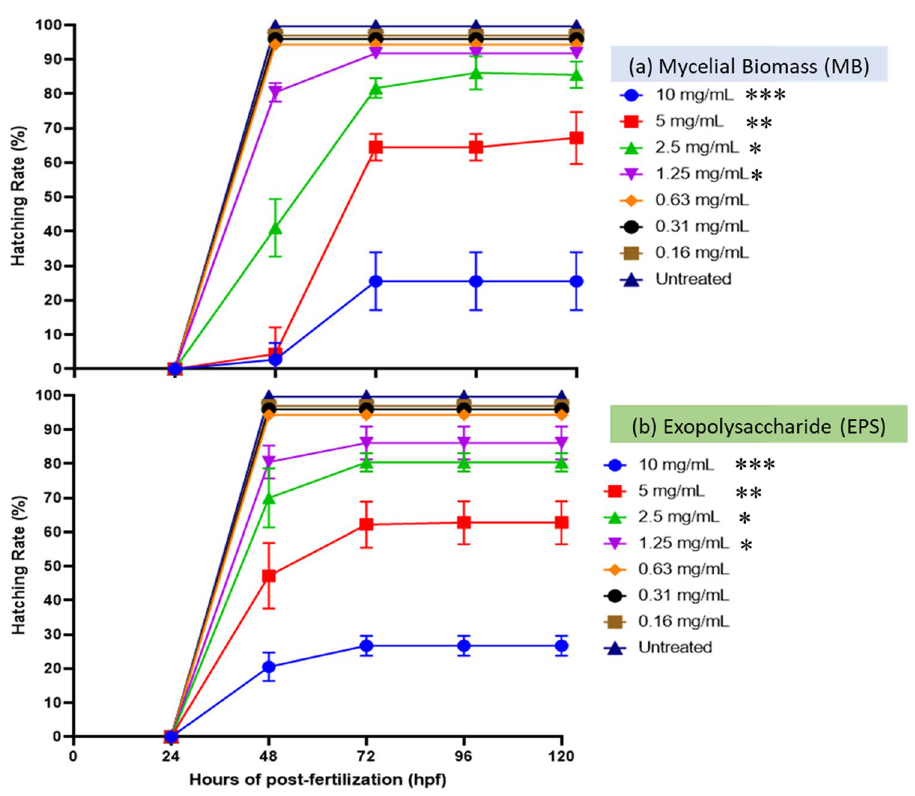
Figure 3. Hatching rate of zebrafish embryos at 0 to 120 HPF with Tiger milk mushroom Lignosus rhinocerus strain ABI, with MB and EPS extract at concentrations of 0.16–10 mg/mL. Symbols: *** p < 0.001, ** p < 0.01 and * p < 0.05. ( a ) For MB, a low hatching rate (< 25%) was observed at concentration 10.0 mg/mL due to a high mortality rate. Meanwhile, ( b ) for EPS, a low hatching rate (< 30%) was observed at concentrations of 10 mg/mL due to a high mortality rate. High hatching rate was observed at concentrations > 1.25 mg/mL (>